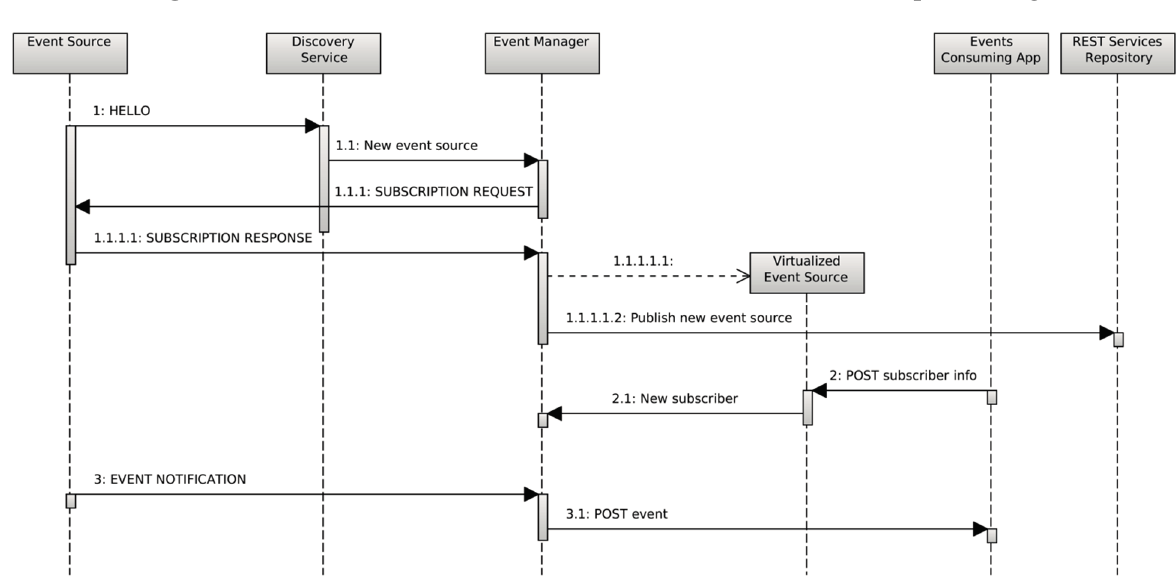
Figure 2. Event source virtualization and event notification and